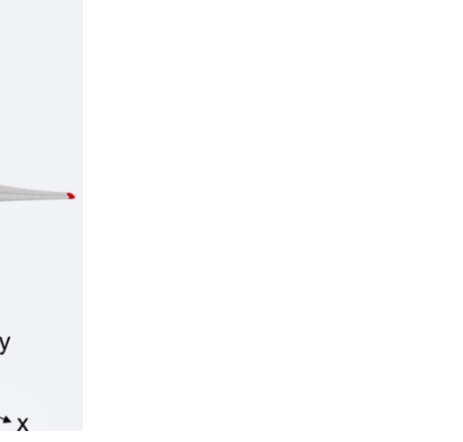
Figure 2. The experiment that was conducted on the robot simulates the motion at the top of a wind turbine excited by wind. The amplitudes have been adapted to show a diverse range of motion. Table 1. Relative amplitudes of the three different